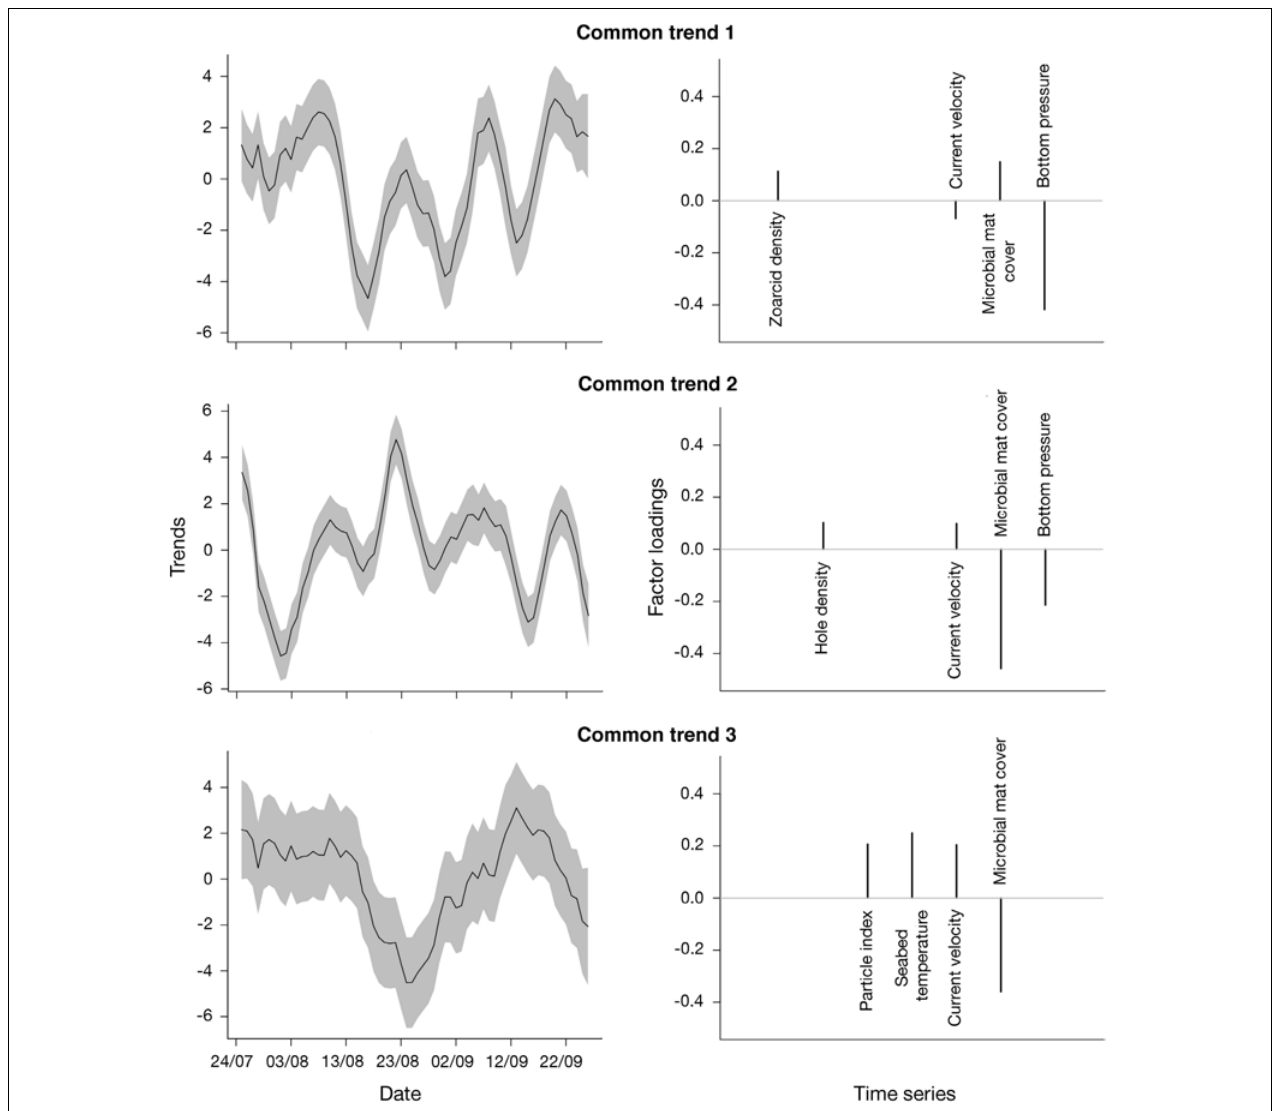
FIGURE 6 | Common trends and factor loadings per trend estimated from a dynamic factor analysis (DFA) model with three common trends and a diagonal and unequal covariance matrix R. Shading around trend values indicate 95% confidence